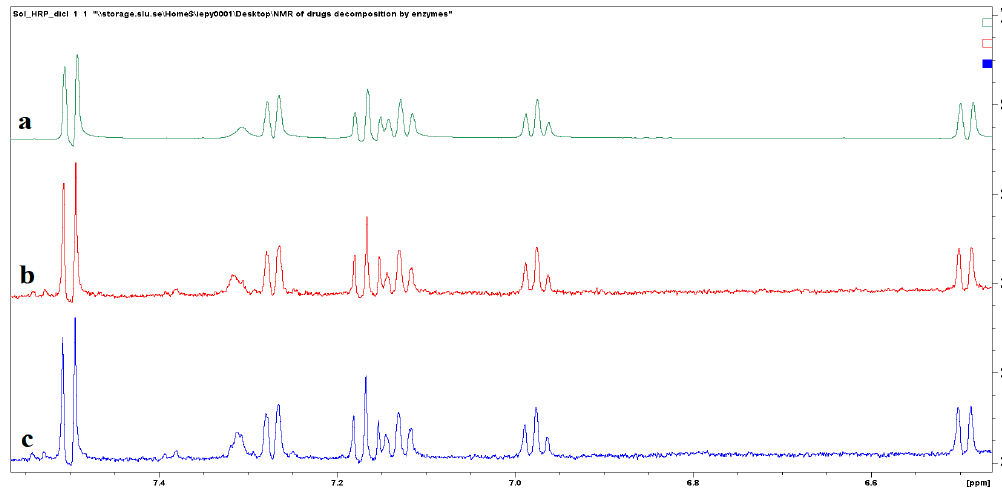
Figure 5. NMR spectra of initial diclofenac ( a ), diclofenac after interaction with sol–gel encapsulated LiP ( b ), and HRP ( c ) composites at pH = 5 during 3 days.